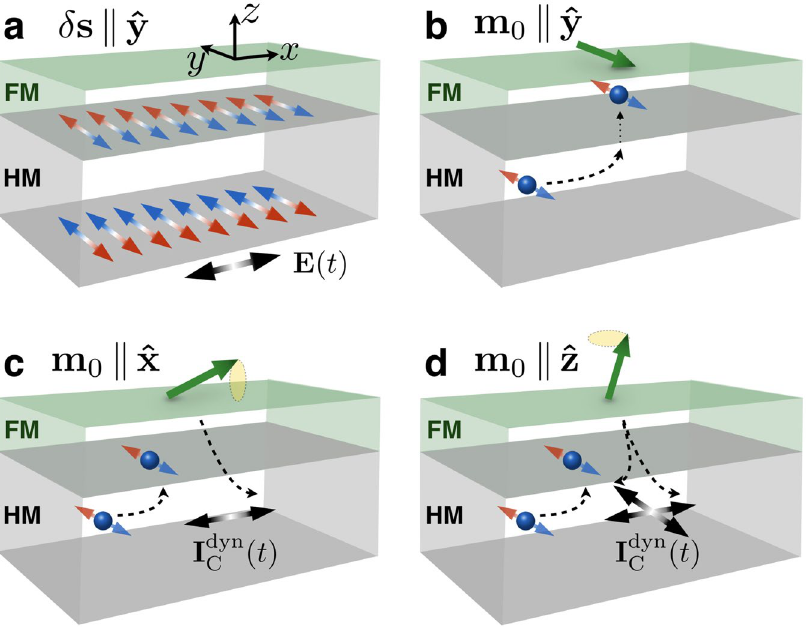
Figure 1. Spin-orbit-related mechanisms in a ferromagnetic/heavy metal bilayer. ( a ) An ac electric field is applied to the whole sample, driving a charge current through the system. The current flowing through the heavy metal (HM) layer in turn generates an oscillatory spin accumulation δ ∝ × ˆ t s z E ( ) on its surfaces through spin Hall and inverse spin galvanic effects. ( b–d ) At the interface between the heavy metal and the ferromagnetic (FM) layer, δ s interacts with its magnetization m magnetization dynamics is driven by the electric field. ( c ) In the case m can be set into precession, pumping charge and spins back into the heavy metal, thereby contributing to the current flowing across the system. ( d ) Depending on the direction of the magnetization, there can be contributions also to the transverse